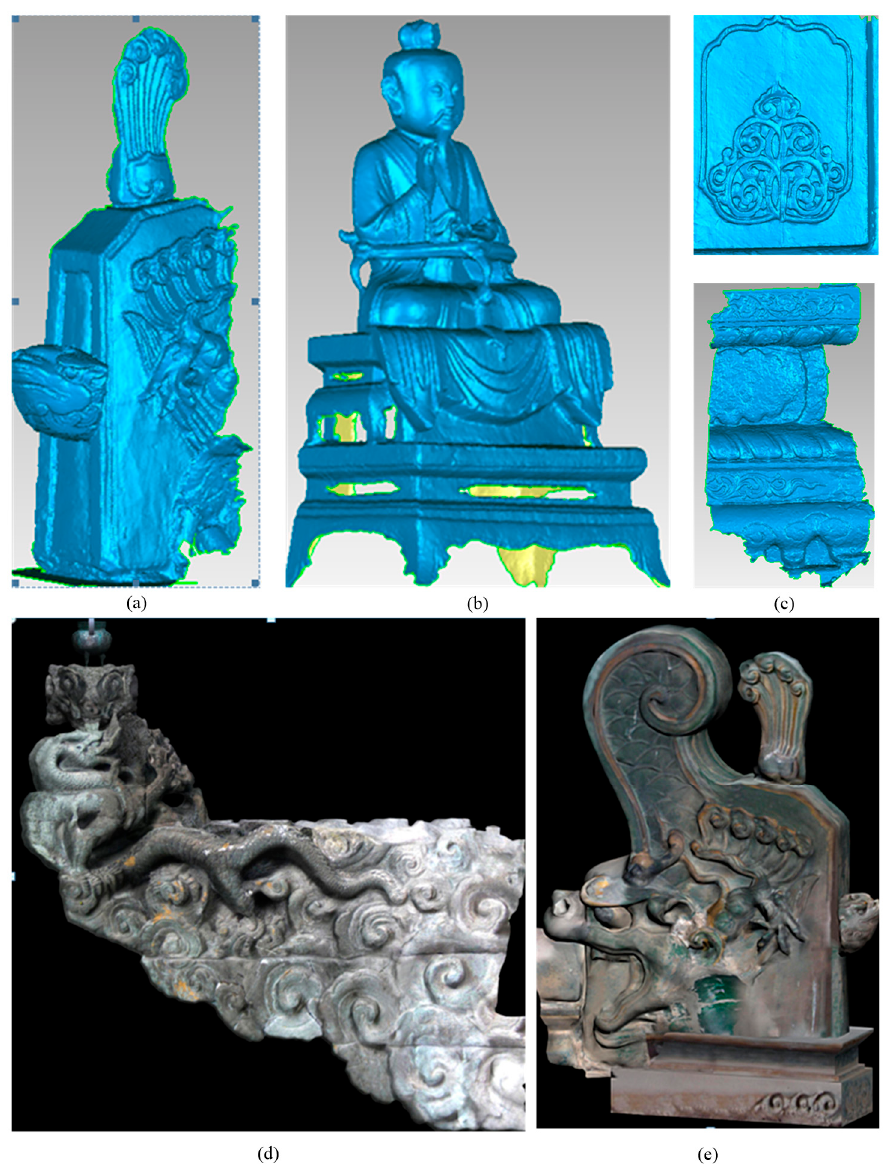
Figure 13. Reality-based 3D modeling of historical relics. ( a ) 3D model of horned beast; ( b ) 3D model of statue; ( c ) 3D model of sculpture; ( d ) texture-mapped 3D model of Longtou Incense; ( e ) texture-mapped 3D model of horned beast.